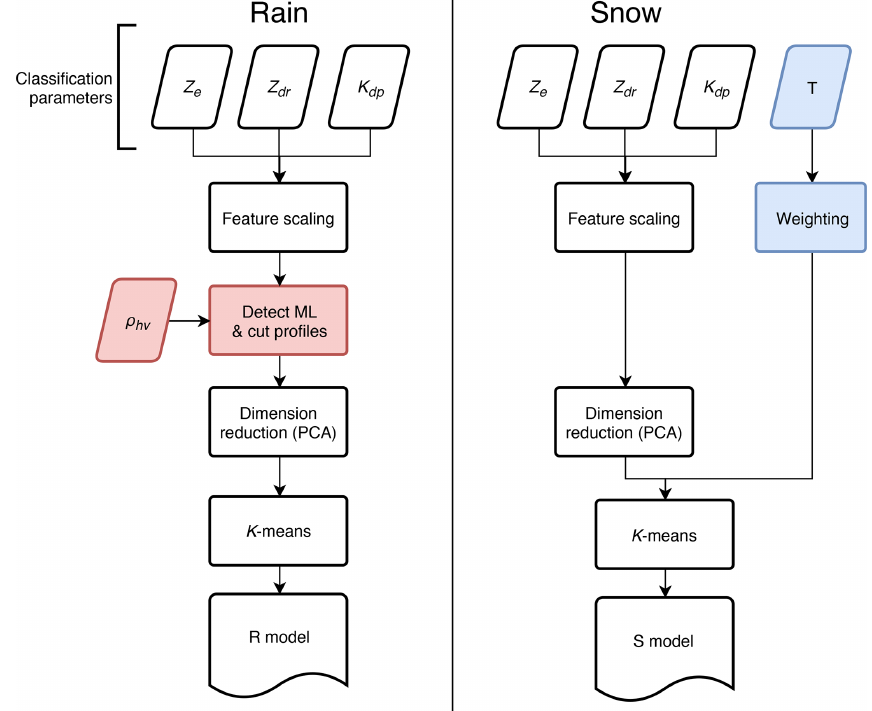
Figure 1. Vertical profile clustering method for creating classification models for rain and snow